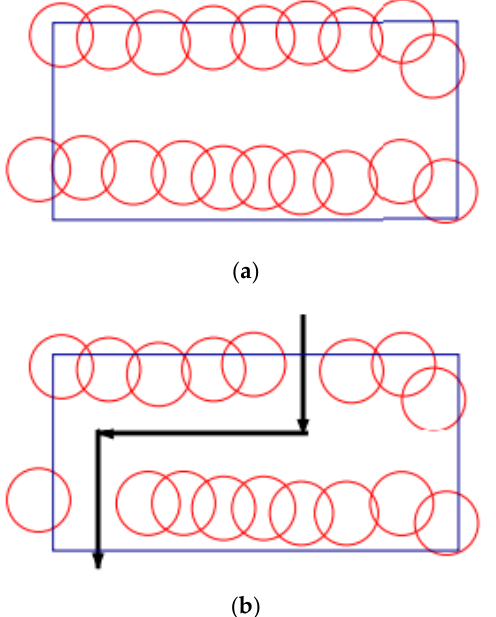
Figure 4. Barrier coverage of the FoI. ( a ) Strong barrier coverage. ( b ) Weak barrier coverage [14]. Deployment problems may be deterministic and random deployment. According to Figure 5a, deterministic deployment determines the nodes’ coordinates prior to their ac ‐ tual distribution. Sensor nodes’ positions are set to reduce network costs, energy con ‐ sumption, high levels of target monitoring, and sensor network lifetimes. However, many ments or deployment costs. In these situations, random deployment is used. Randomly, Nodes are spread throughout the FoI, as illustrated in Figure 5b. Therefore, the WSN is domly deployed [1,14].